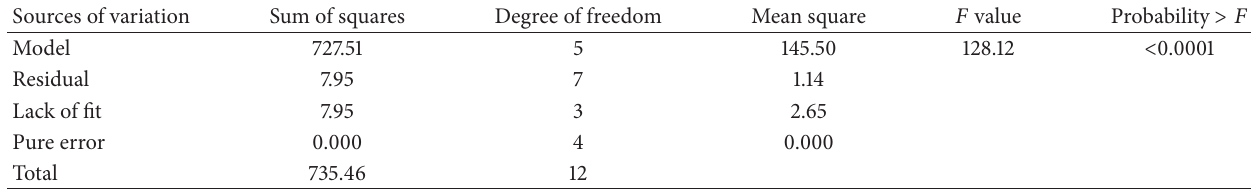
Table 9: Analysis of variance (ANOVA) for quadratic model for removal